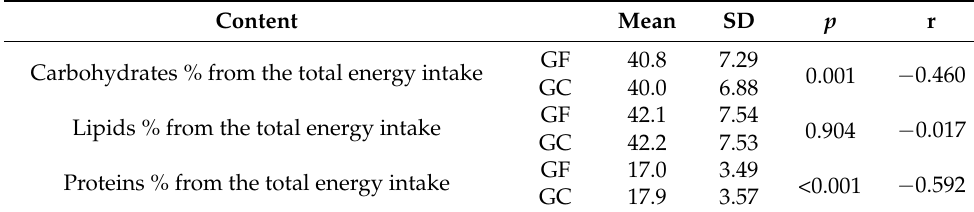
Table 3. Macronutrient (carbohydrates, proteins, and lipids) percentage from the energy intake and fiber intake (g/d) for males and females following a diet with gluten-free rendered foods and a diet with equivalent products with